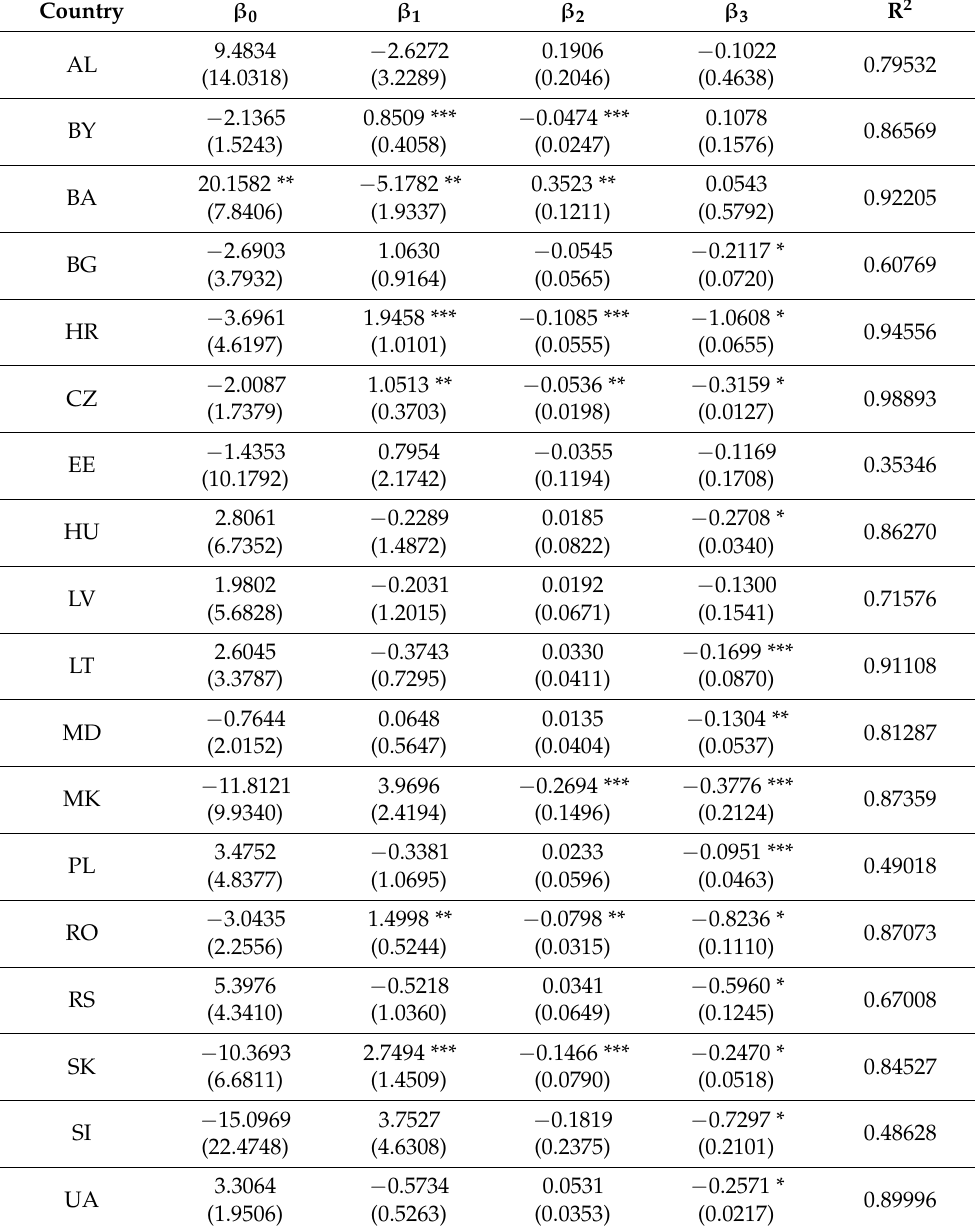
Table 6. Estimation of model parameters for independent variables GPD and